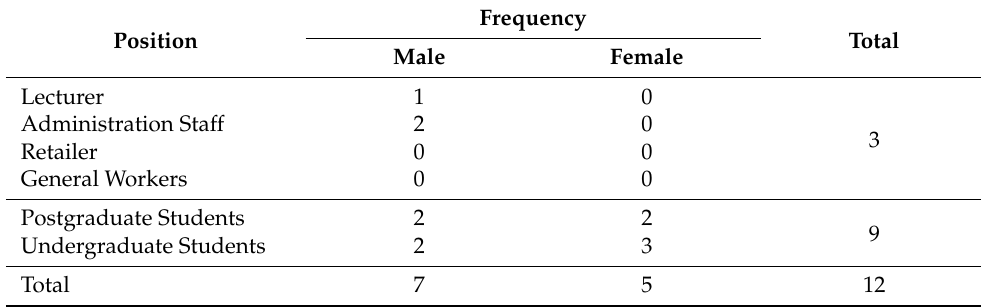
Table 4. In-Depth Interview’s Respondent